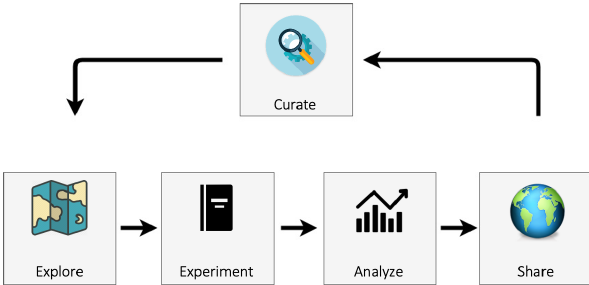
Figure 1. An overview of the components of the eWaterCycle plat- form. The design of the eWaterCycle platform closely follows the typical workflow of running hydrological